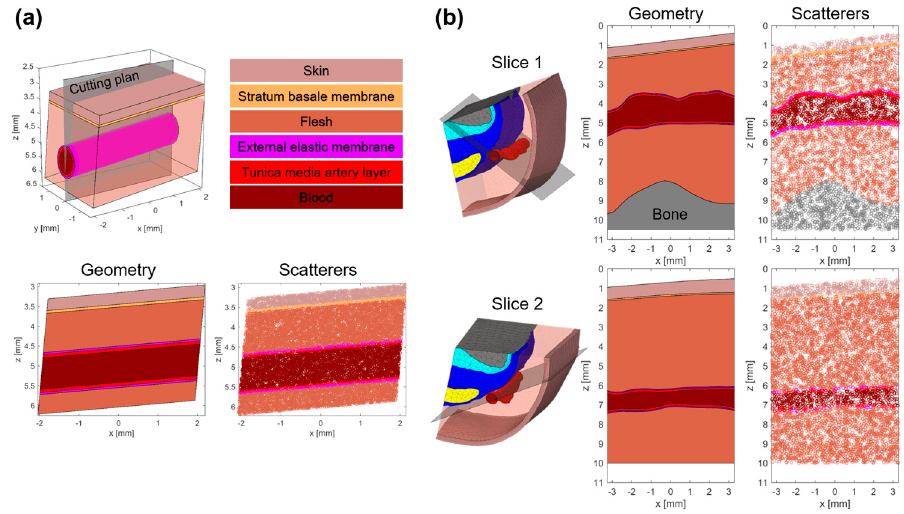
Figure 6. Geometries and scatterers used for computing the numerical ultrasound phantoms: ( a ) cylindrical basic artery; ( b ) true artery with two imaging sections, from [68].